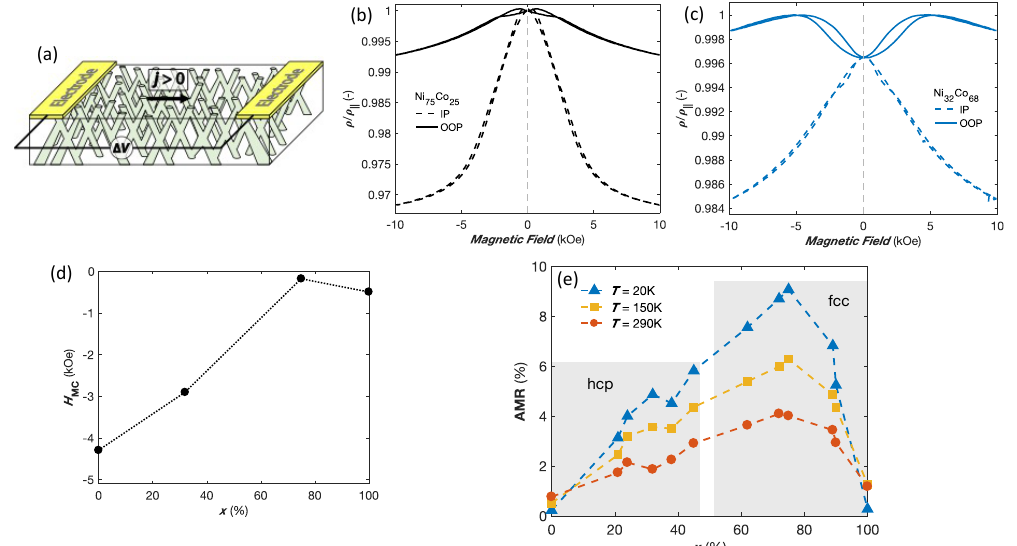
Figure 12. ( a ) schematic representation of an electrode design for electrical measurement of CNW network embedded in 3D porous PC membrane; ( b , c ) magnetoresistance curves for ( b ) Ni 75 Co 25 and ( c ) Ni 32 Co 68 CNW networks measured at room temperature by applying the external field in the OOP (continuous lines) and IP (dashed lines) directions; ( d ) variation of the magnetocrystalline anisotropy field H MC with respect to the Ni content (x) for the Ni x Co 1-x CNW networks; ( e ) variation of the AMR ratio with respect to the alloy composition at T = 20 K, 150 K, and 290